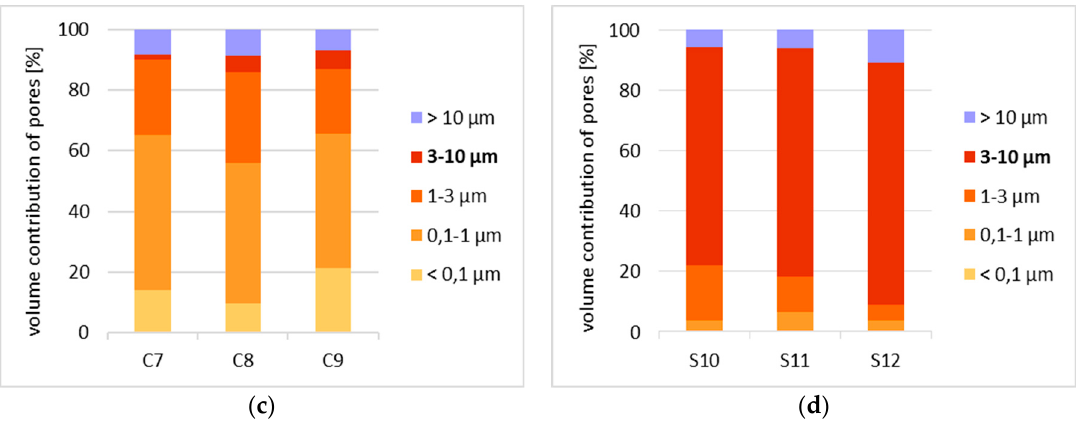
Figure 11. Classification of pores in bricks damaged in the form of powdering P1, P2 and P3 ( a ), flaking F4, F5 and F6 ( b ), cracking C7, C8 and C9 ( c ) and standard S10, S11 and S12 ( d ).